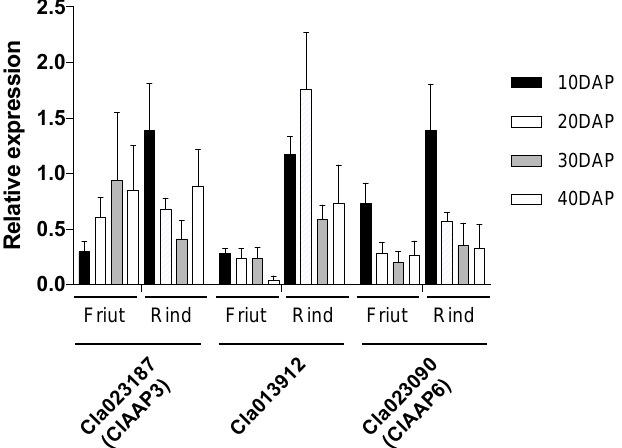
Figure 1. Expression of putative amino acid transporters in the fruit tissues. The relative expression level of each gene was measured by qRT-PCR using gene-specific primers shown in Table S1. RNA samples were extracted from fruits and rind tissues at 10, 20, 30, and 40 days after pollination (DAP). The expression levels were normalized using actin gene. The data were obtained from three biological replicates.